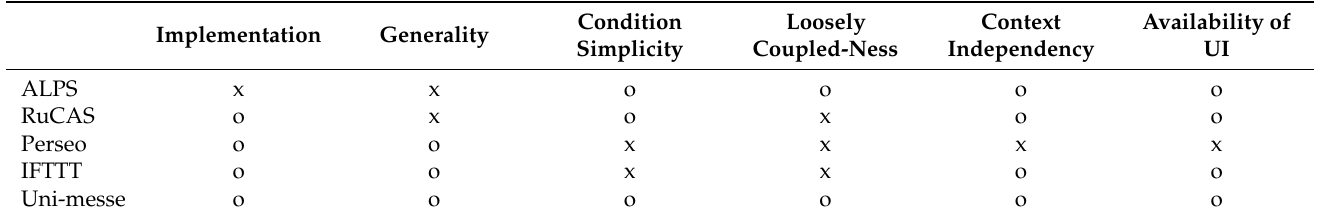
Table 3. The results of the comparison between Uni-messe and other existing rule-based